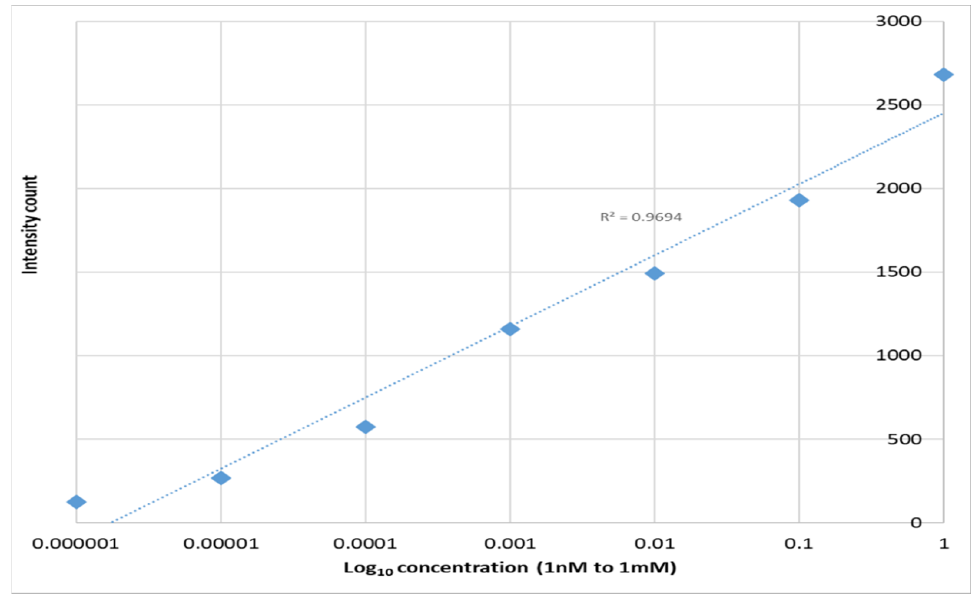
Figure 13. 1364 cm − 1 Raman signal strength vs. Rhodamine 6G concentration on epoxy SERS.